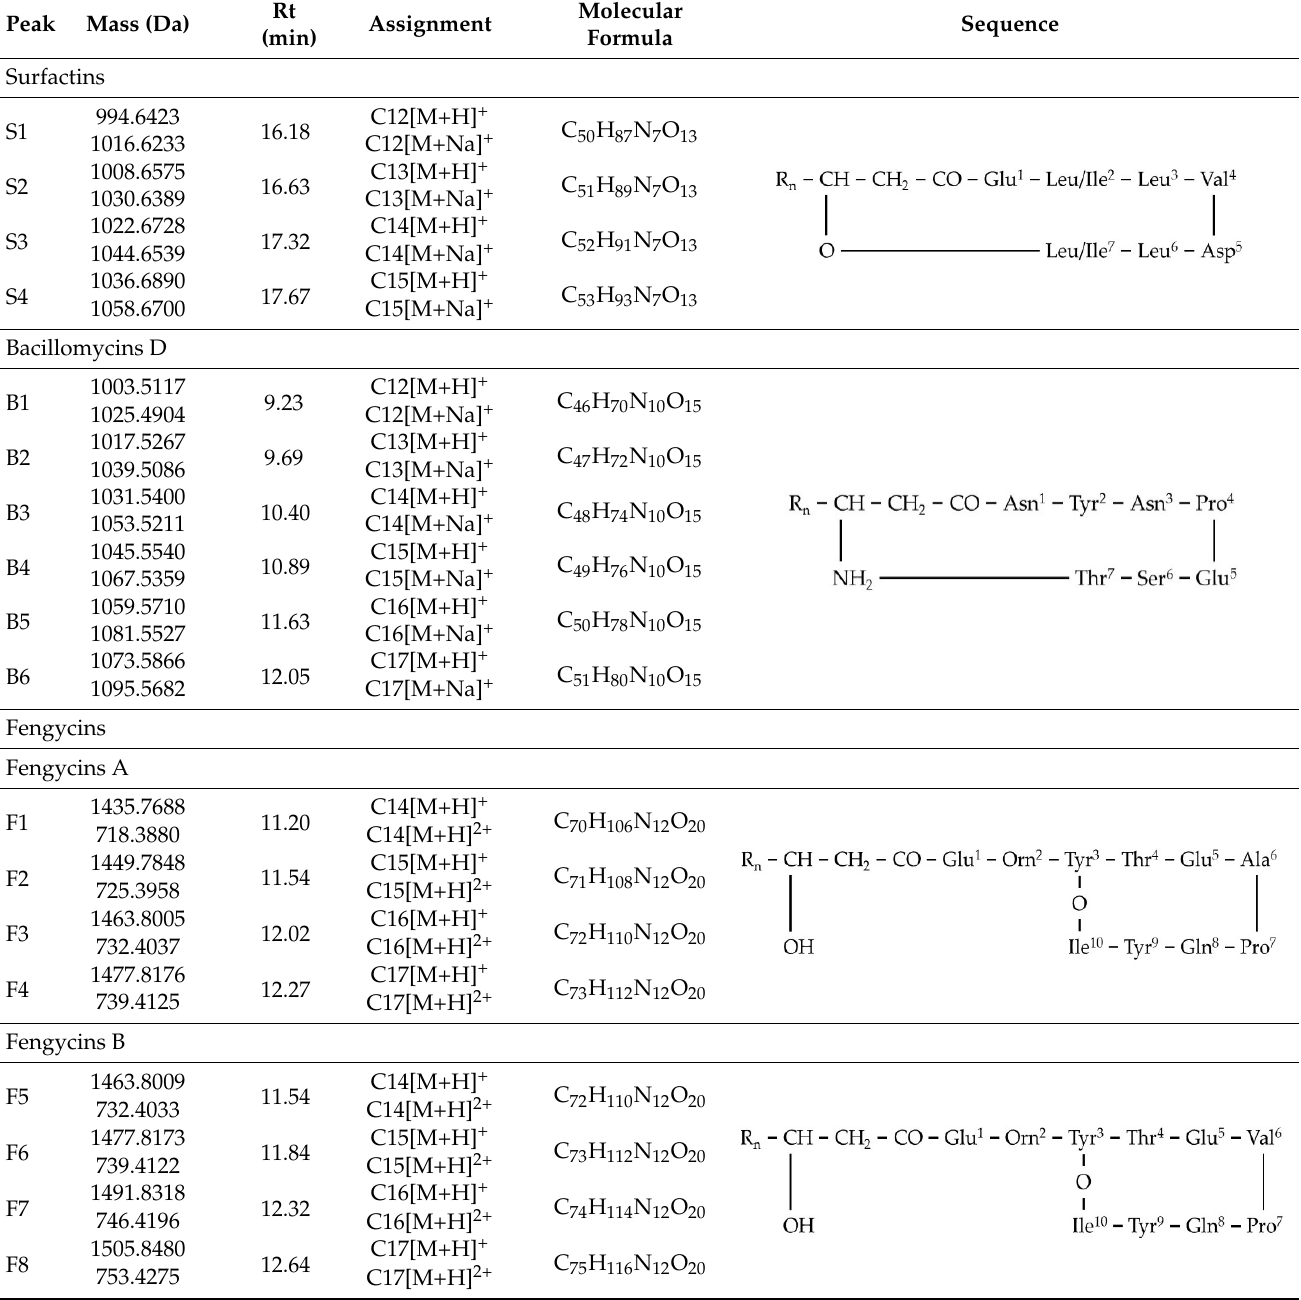
Table 1. Annotated lipopeptides (LPs) of the olive tree endophytic isolate Bacillus sp. PTA13. LPs were recorded at an average Δ ppm < 2 employing an LC-Hybrid LTQ-Orbitrap Discovery platform. Peak Mass (Da) Rt (min) Molecular Sequence Assignment Formula Surfactins S1 1016.6233 C12[M+Na] +